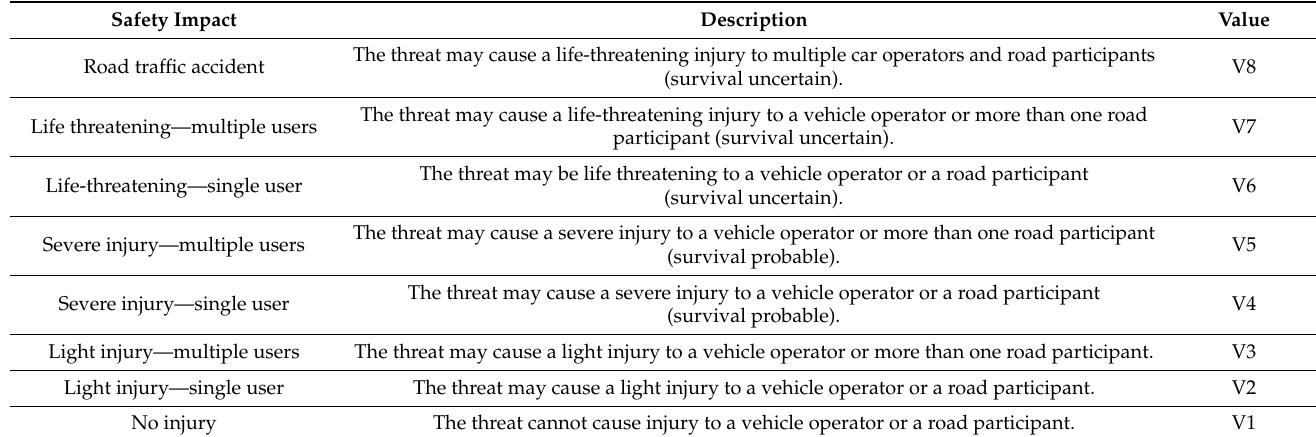
Table 5. Example safety impact rating criteria for TARA